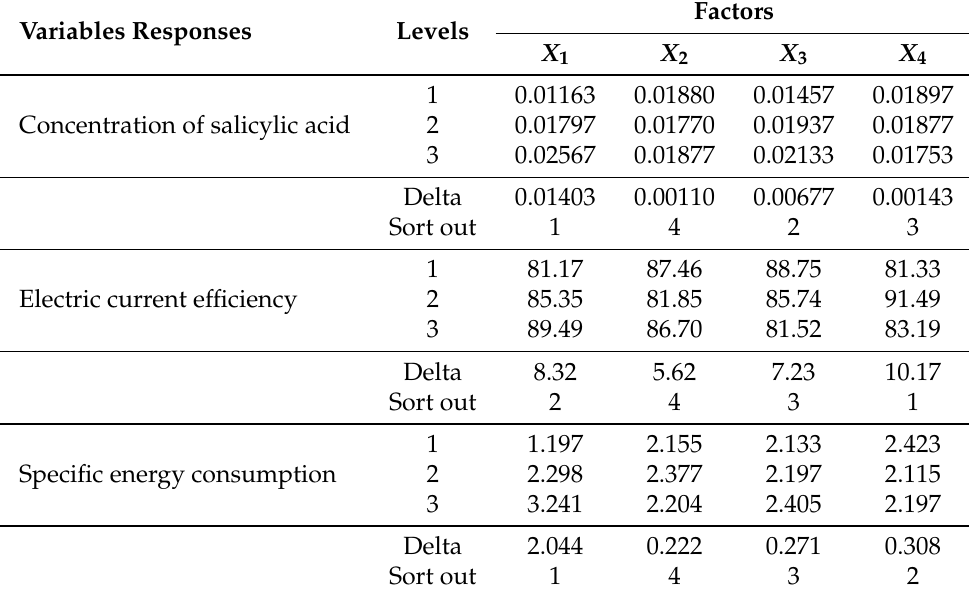
Table 6. Order of influence of response parameters.